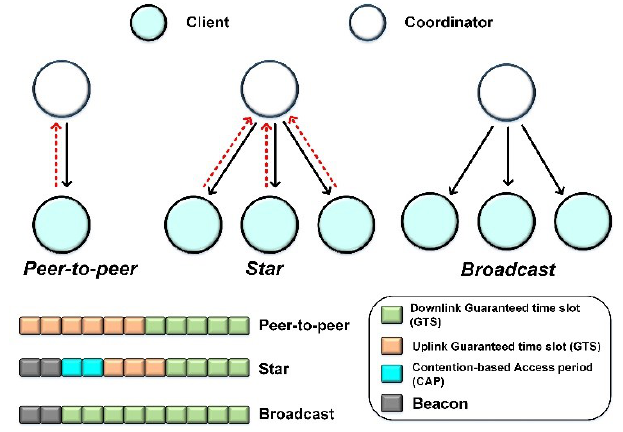
Figure 1. Network topologies defined in IEEE 802.15.7 standard and its example the frame structure usage in different topologies, reproduced from [7]